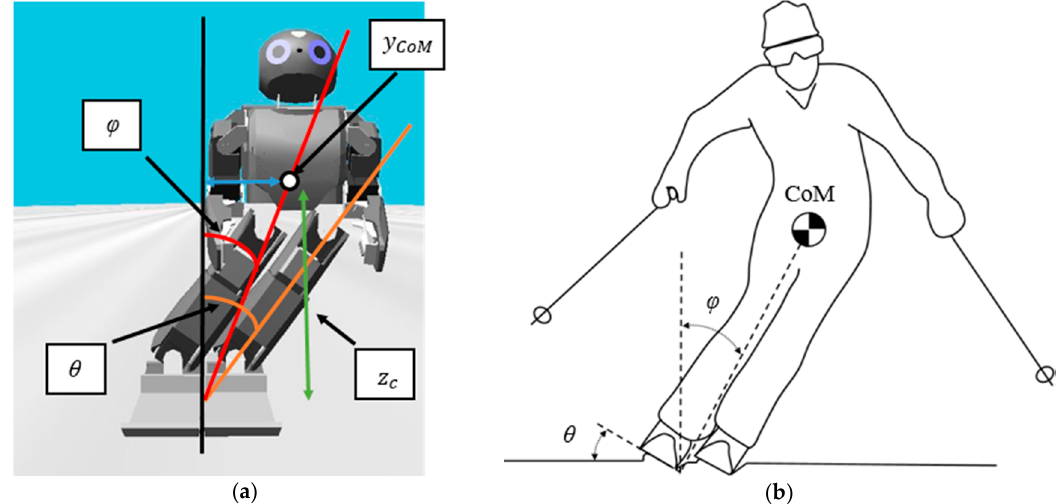
Figure 3. ( a ) 𝜑 is the lean angle between 𝑦 (cid:3004)(cid:3042)(cid:3014) and middle of the vertical line, 𝜃 is an edging angle, 𝑧 (cid:3030) is a constant CoM height normal to the snow surface; ( b ) Approximation of 𝜑 and 𝜃